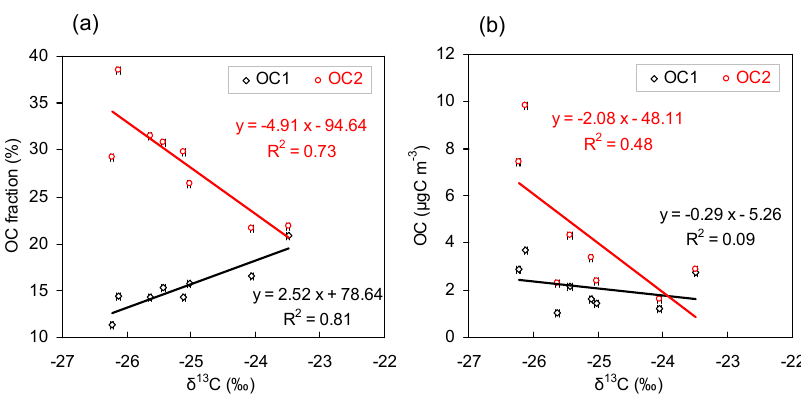
Fig. 13. Scatter plot of δ 13 C TC versus OC1 and OC2 fractions in total OC during the pollen episodes. The error bar in x-axis represents the analytical error of δ 13 C TC